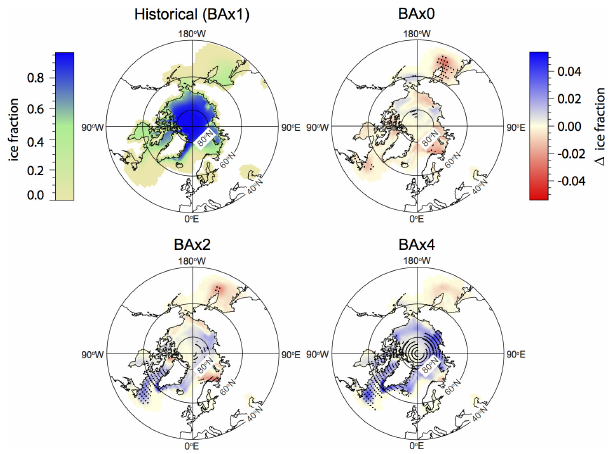
Fig. 9. Mean historical and changes to annual Northern Hemisphere sea ice coverage. Stipples represent 95% statistical